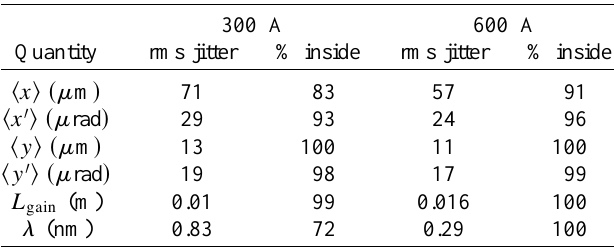
TABLE V. Results of 300 randomized simulations with sweep- determined tolerance levels for R 56 (cid:1) 2 65 mm.